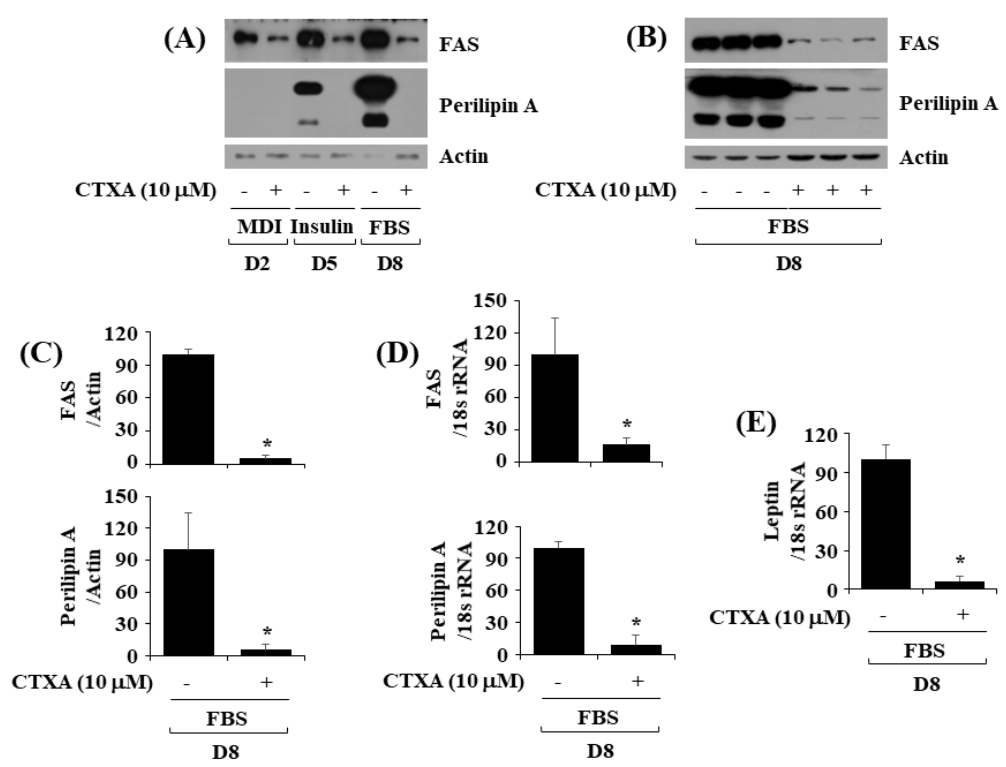
Figure 3. Effects of CTXA on expression level of perilipin A and fatty acid synthase (FAS) during 3T3-L1 preadipocyte differentiation. ( A ) 3T3-L1 preadipocytes were differentiated with induction medium containing MDI, insulin, and FBS in the absence (control; 0.1 % DMSO) or presence of CTXA (10 µM), and harvested at day 2 (D2), D5, and D8, respectively. At each time point, whole cell lysates were prepared and analyzed by immunoblot analysis with respective antibodies. ( B ) Western blot analysis in triplicate experiments on D8. ( C ) Densitometry analysis of ( B ). * p < 0.05 compared to control. ( D , E ) Total cellular RNA was extracted at D8 and analyzed by real-time qPCR with respective primers. Data are mean ± SE of three independent experiments. * p < 0.05 vs. control.